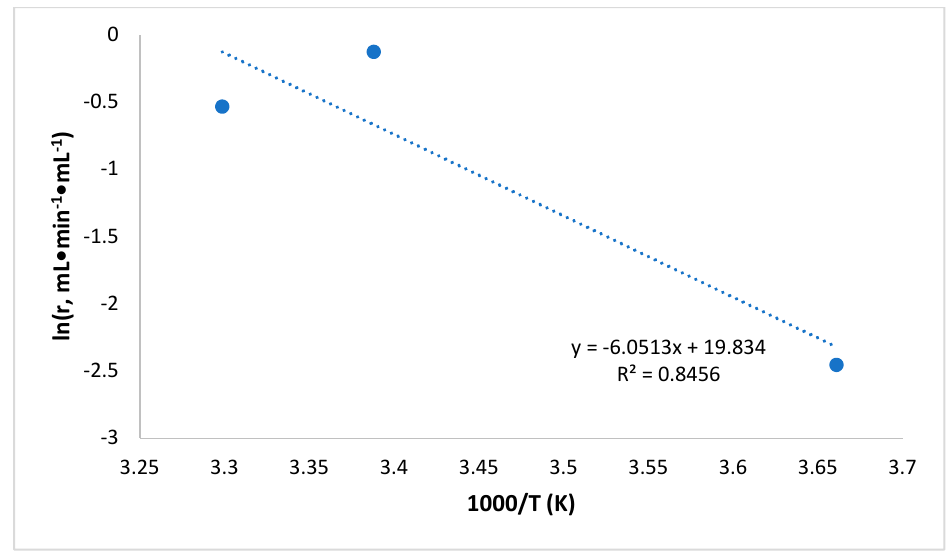
Figure 8. Volume of hydrogen gas produced over time generated by the hydrolysis reaction of sodium borohydride and water, as catalyzed by the produced silver nanoparticle network (0, 22, and 30 °C).